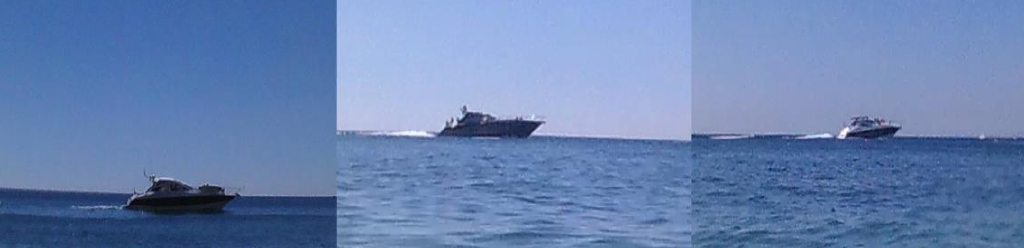
Figure 7. Continuous flow of pleasure boats and tourist transportation for visiting the caves along the rocky coast of Lagoa, Silves and Albufeira. These three vessels were photographed within 5 min, moving at great speed and less than 100 m from the beach, making the engine noise very audible.